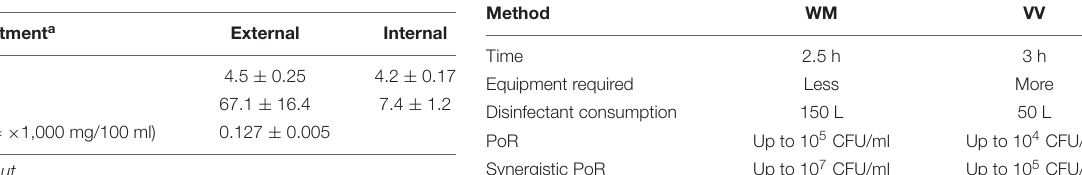
TABLE 8 | The average concentration of calcium in treated meat with or without CEL disinfectant.